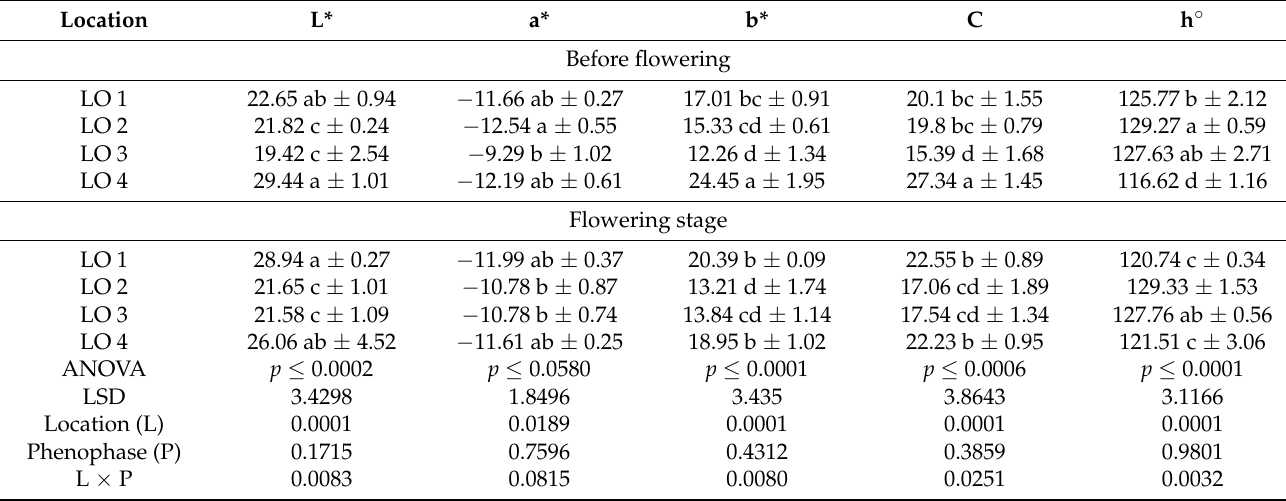
Results are expressed as mean ± standard deviation. Different letters indicate significant differences between mean values. L × P—interaction between location and phenophase. The chromaticity parameters of fresh wild garlic leaves of selected wild populations Table 2. Chromaticity parameters of wild garlic leaves. from different locations and plant phenophases (before and during flowering) are presented different factors, locations and phenophases. Depending on the phenophase of the plant, L* values ranged from 19.42 to 29.44 with an average value of 23.33 irrespective of the location, while higher L* values were obtained in the flowering phase with an average value of